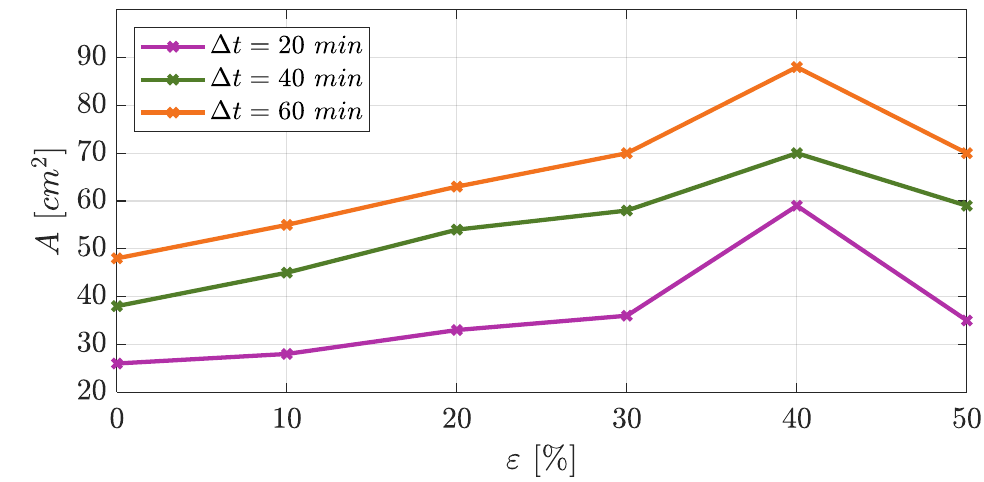
Figure 8. Sand-trapping efficiency expressed as cross-sectional area of dune for fences with different porosity values over time 328 (adapted from [17,22]).